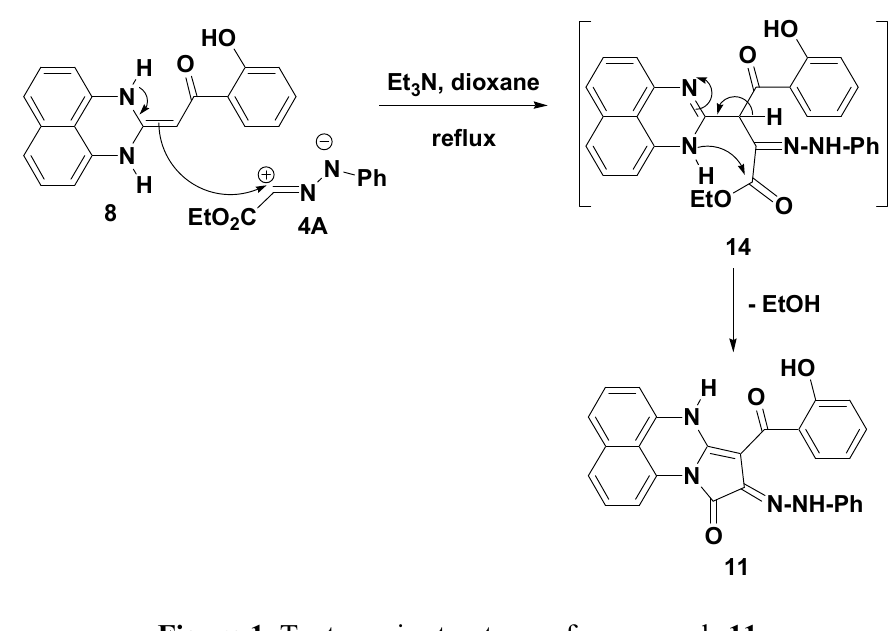
Figure 1. Tautomeric structures of compounds 11